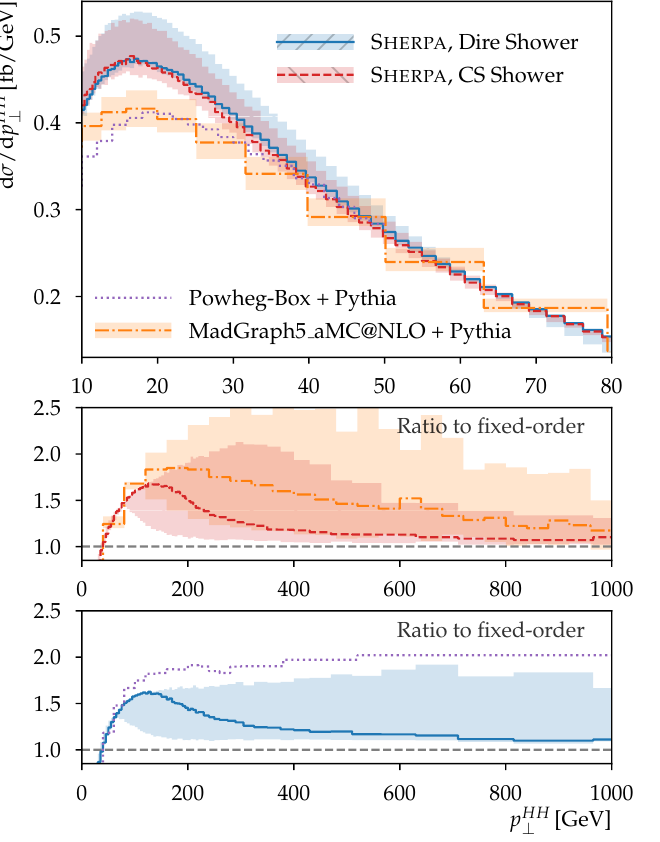
Figure 7 . Comparison with NLO parton shower matched results from the literature. The lower panels show ratios to the (cid:12)xed-order prediction and cover a wider range of p HH panel. The uncertainties on parton shower matched predictions were obtained by varying (cid:22) PS